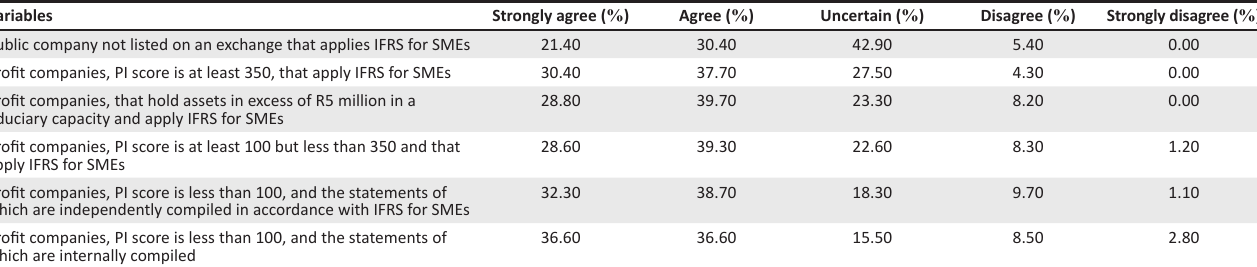
TABLE 1: Extent of practitioners’ belief that the International Financial Reporting Standards for small and medium-sized entities had relieved the burden of financial reporting. Variables Strongly agree ( % ) Agree ( % ) Uncertain ( % ) Disagree ( %